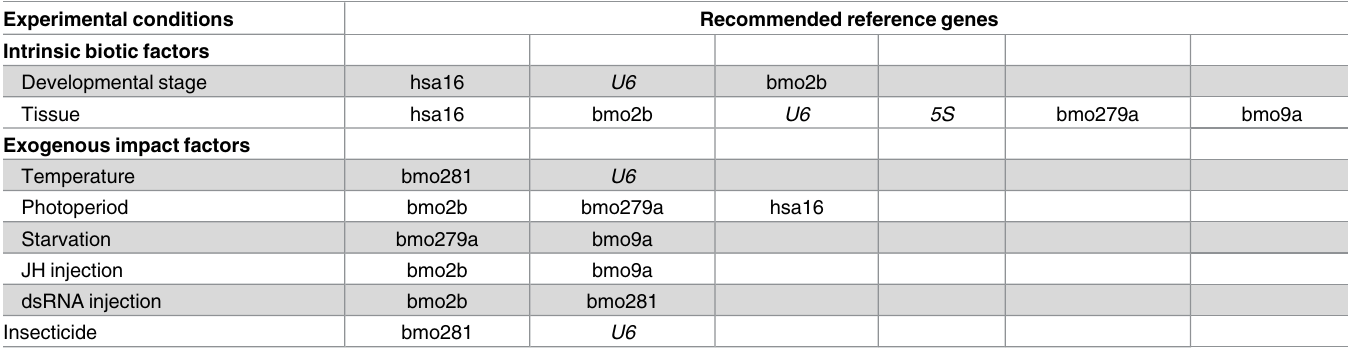
Table 6. Recommended referencegenes for expressional qualification of microRNA in G . molesta under different experimental conditions. Experimental